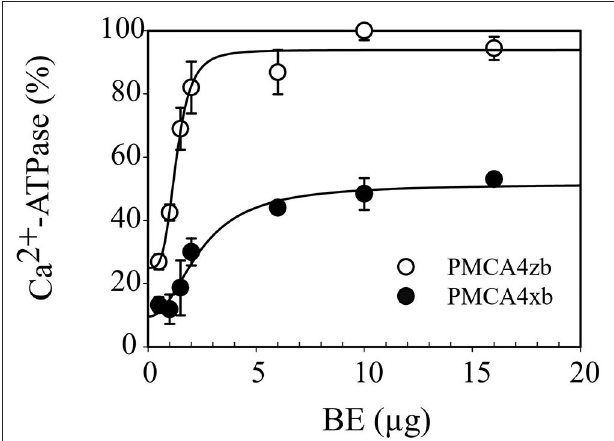
FIGURE 6 | Activation of purified PMCA4xb-GFP and PMCA4zb-GFP by acidic lipids. The Ca 2 + -ATPase activity was measured as indicated in Figure 5 . PMCA4xb-GFP and PMCA4zb-GFP proteins (1 µ g) were supplemented with the indicated amount of acidic lipid brain extract (BE). The concentration of Ca 2 + was 10 µ M. The continuous lines represent the best fitting of the data to a Hill equation v = v 0 + v BE *[BE] nH /([K 0.5BE ] nH + [BE] nH ) with the following parameters. For PMCA4xb, v 0 = 9 ± 5%, v BE = 42 ± 8%, K 0.5BE = 2.4 ± 0.5 µ g, nH = 2 ± 1; for PMCA4zb; v 0 = 25 ± 7%, v BE = 69 ± 7%, K 0.5BE = 1.3 ± 0.1 µ g, nH = 4 ±